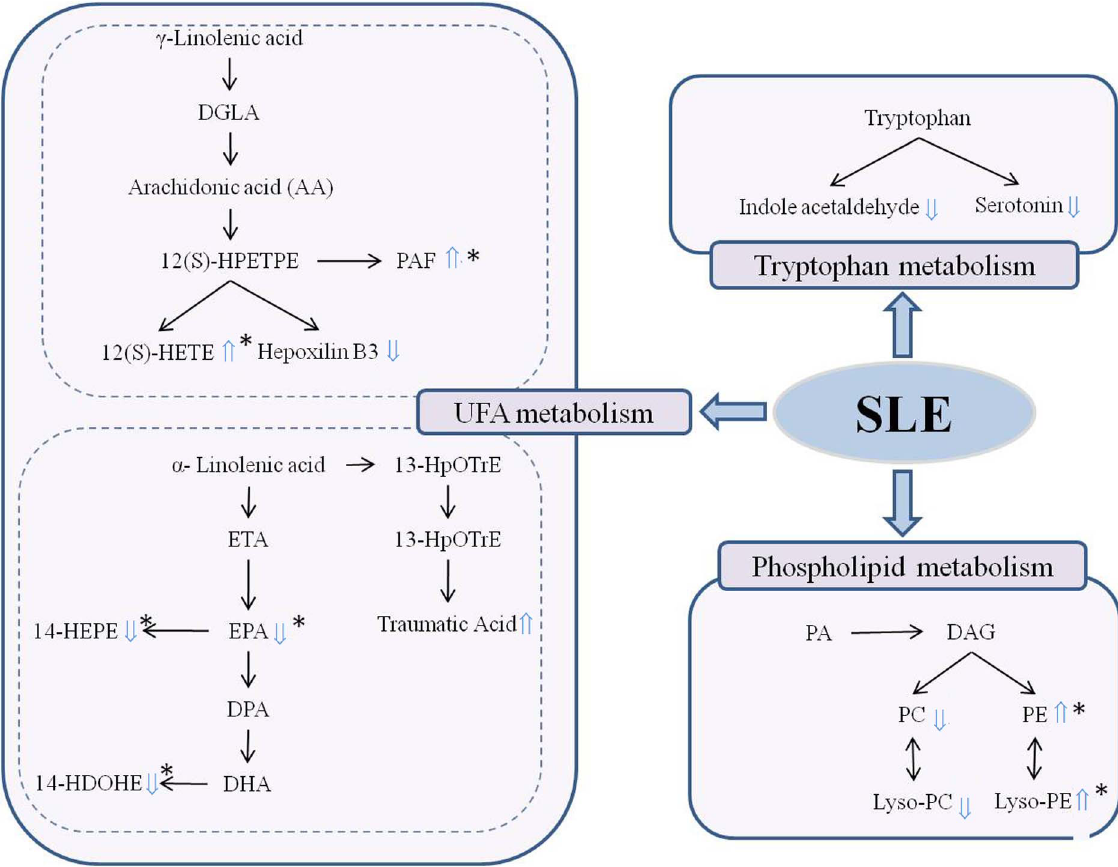
Figure 7. The perturbed metabolic network associated with SLE. The differential metabolite levels of the SLE model group compared to the control group were marked with ( X ) upregulated and ( Y ) downregulated. (*Differential metabolites which could be effectively regulated by JP).